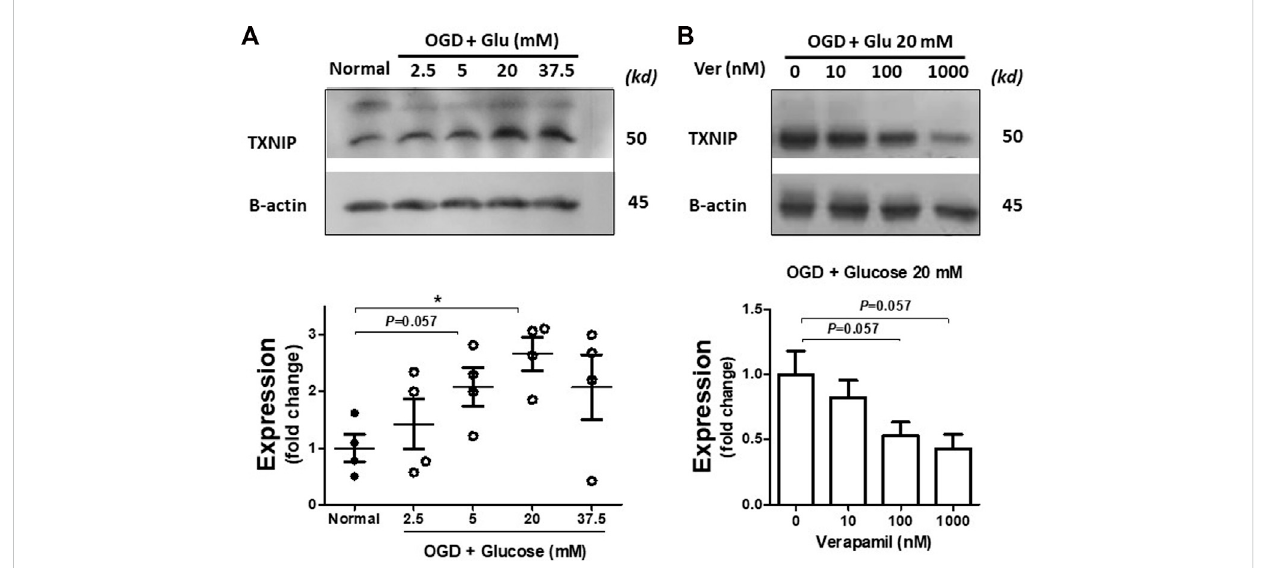
FIGURE 1 Verapamil decreases TXNIP upregulation induced by OGD-HGr. PCN cultures were exposed to OGD and incubated in normal conditions with increasing glucose concentrations (2.5, 5, 20, and 37.5 mM) for 24 h. Normal and OGD-HGr PCN cultures were then immunoblotted for TXNIP